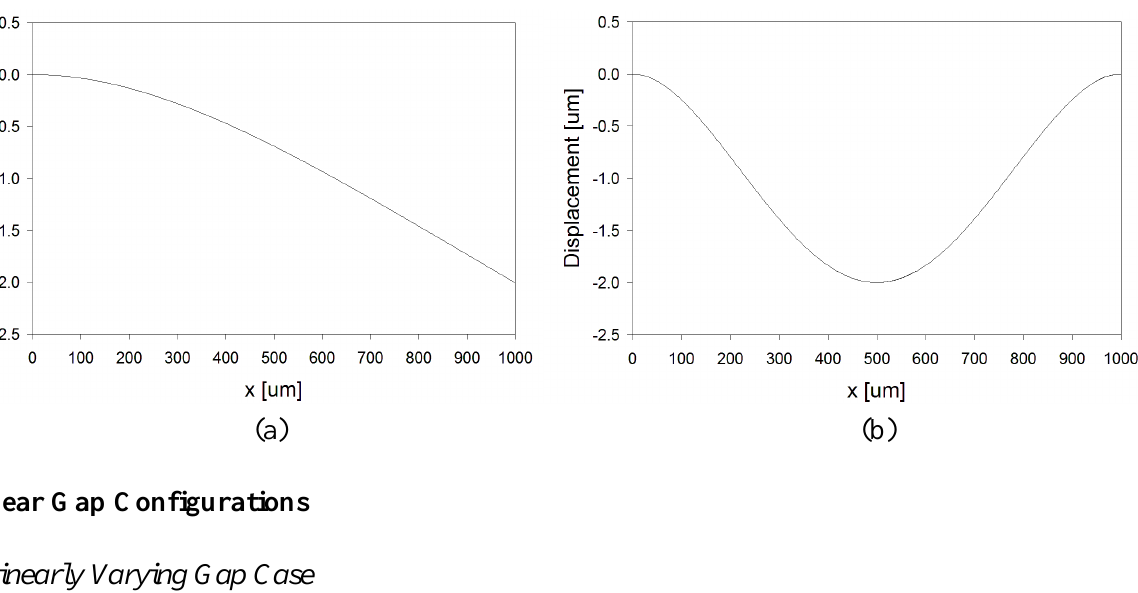
Figure 5. Constant gap beam displacement profiles (a) cantilever (b)